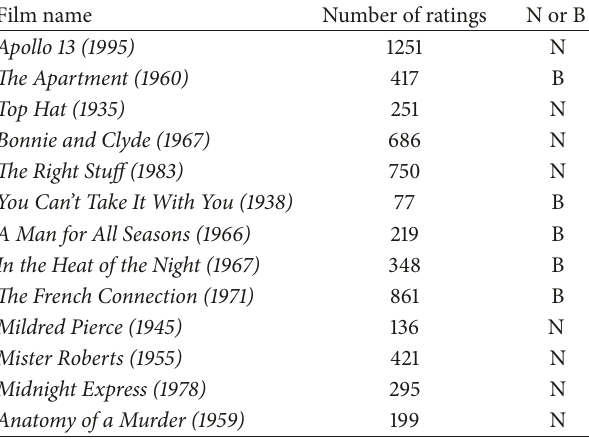
Table 4: The nominated movies for an Academy Award identified by IB method in the top-100 places, but not in the lists of the other six methods in the M2 dataset . The nominated year of each movie is presented in brackets. B means the movie won an Academy Award. N means the movie was only nominated. Movies are ranked according to their quality scores given by the IB